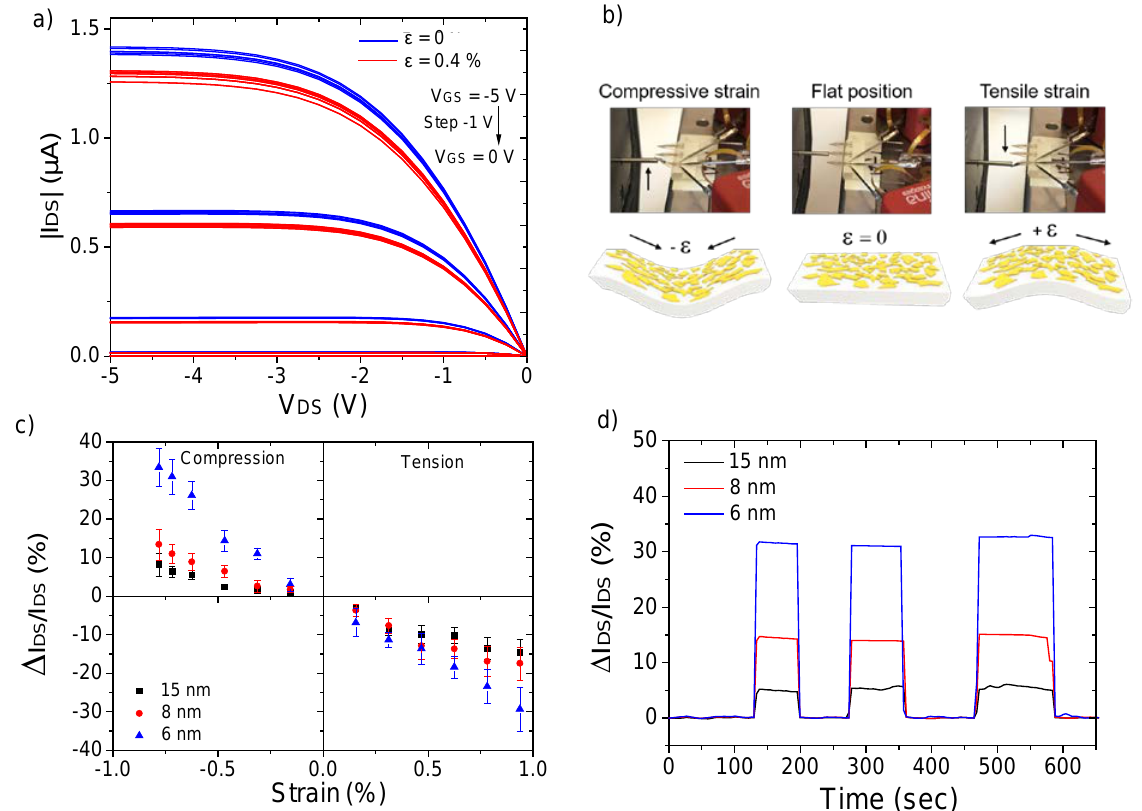
Figure 2. ( a ) Output curves of an 8 nm thick DNTT-based organic field-effect transistor (OFET) sensors under 0.4% of tensile strain, ( b ) optical images of the sensors subjected to compressive strain, in its flat position and under tensile strain with their corresponding schematics illustrating the modification of the active layer morphology under applied strain, ( c ) relative change of drain current of 6, 8 and 15 nm thick sensors under applied compressive and tensile strain at V DS = − 5 V and ( d ) relative change of drain current of 6, 8 and 15 nm thick active layer when subjected to 0.75% of compressive strain at V DS = − 5 V.